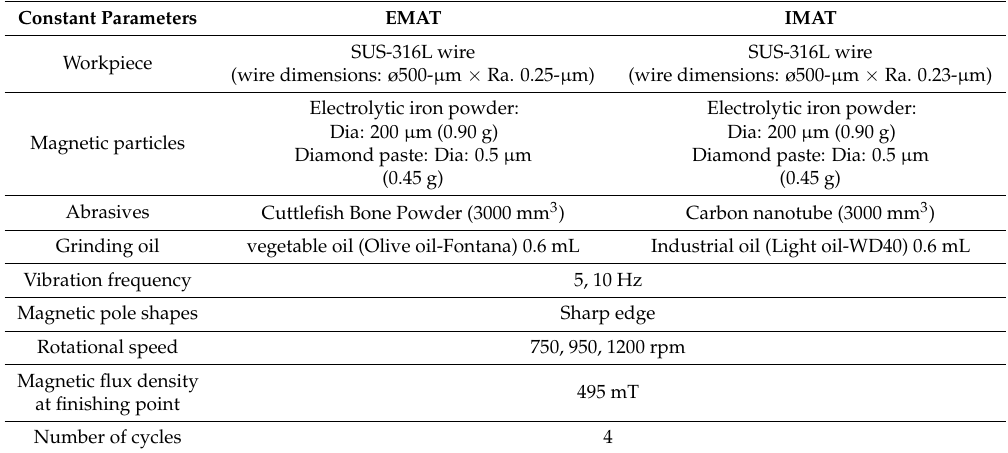
Table 3. Experimental conditions for both finishing